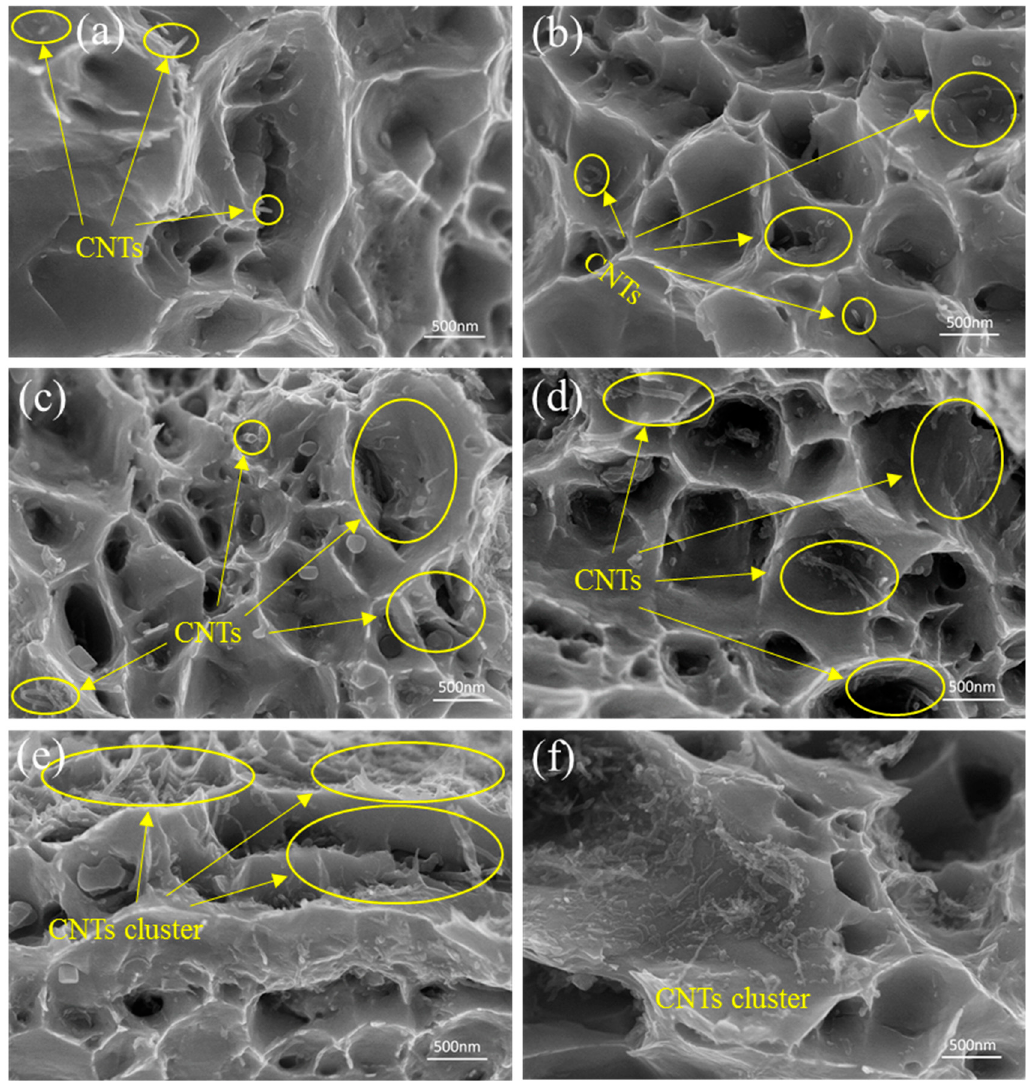
Figure 7. ( a ), ( c ), ( e ) SEM images of fracture morphology for 0.1 wt %, 0.3 wt %, and 0.5 wt %; ( b ), ( d ), Figure 7. ( a , c , e ) SEM images of fracture morphology for 0.1 wt %, 0.3 wt %, and 0.5 wt %; ( f ) SP-0.1 wt %, SP-0.3 wt %, and SP-0.5 wt % CNT-Cu composites, respectively. ( b , d , f ) SP-0.1 wt %, SP-0.3 wt %, and SP-0.5 wt % CNT-Cu composites,